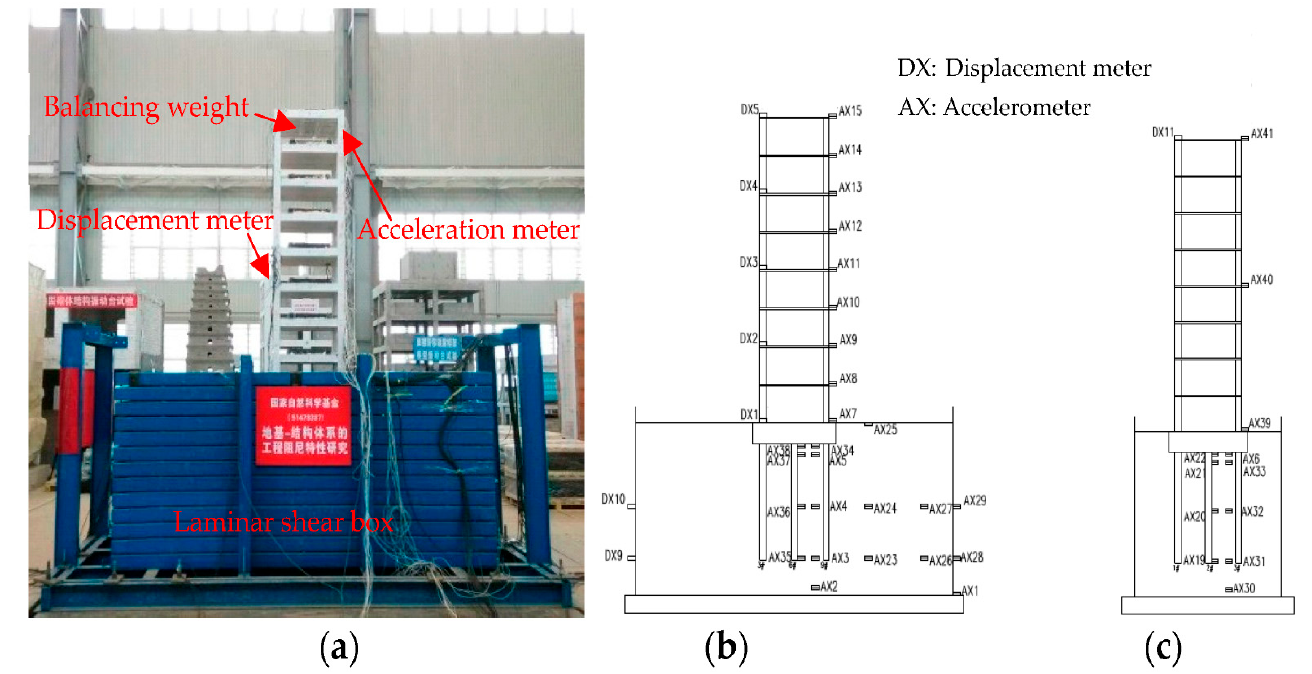
Figure 8. Test Model and Testing Points Layout: ( a ) Test Model, ( b ) Measuring points of acceleration and displacement for 1-1 Section, ( c ) Measuring points of acceleration and displacement for 2-2 Section. Table 2. Test Program of the Shaking Table Tests.